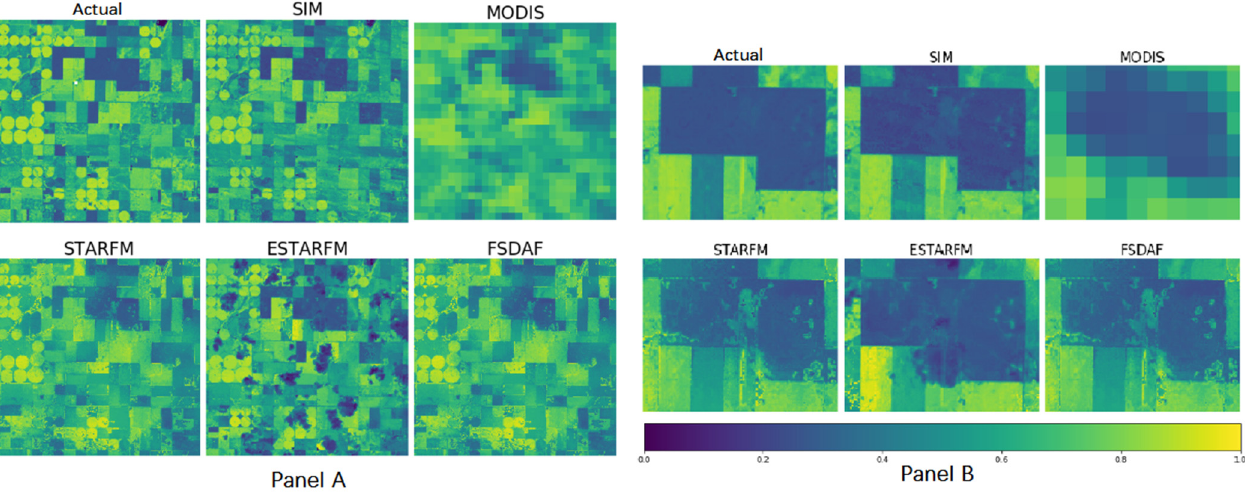
Figure 7. Actual and predicted NDVI images using different methods at date of year (DOY) 191. A zoomed-in area of all images is shown in Panel B. Table 5. Accuracies of different methods for NDVI and LAI prediction at the CSD area from DOY 191. NDVI LAI